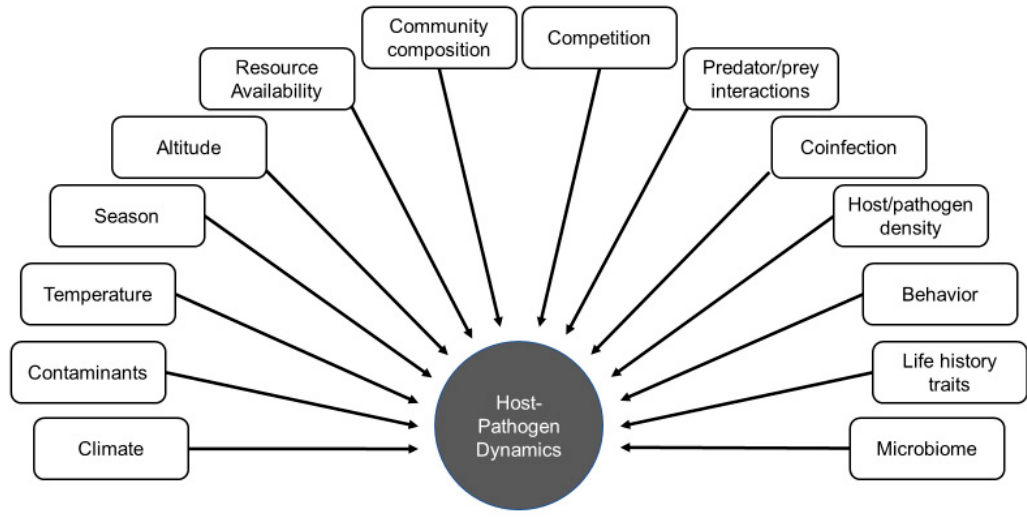
Figure 1. Potential abiotic and biotic factors that may influence host–pathogen dynamics in amphibian disease systems. Among the major threats to amphibians are emerging infectious diseases (EIDs). Several prominent pathogens and associated EIDs affect amphibian populations worldwide. Batrachochytrium dendrobatidis (hereafter referred to as Bd) is a pathogenic fungus that causes amphibian chytridiomycosis [13–15].